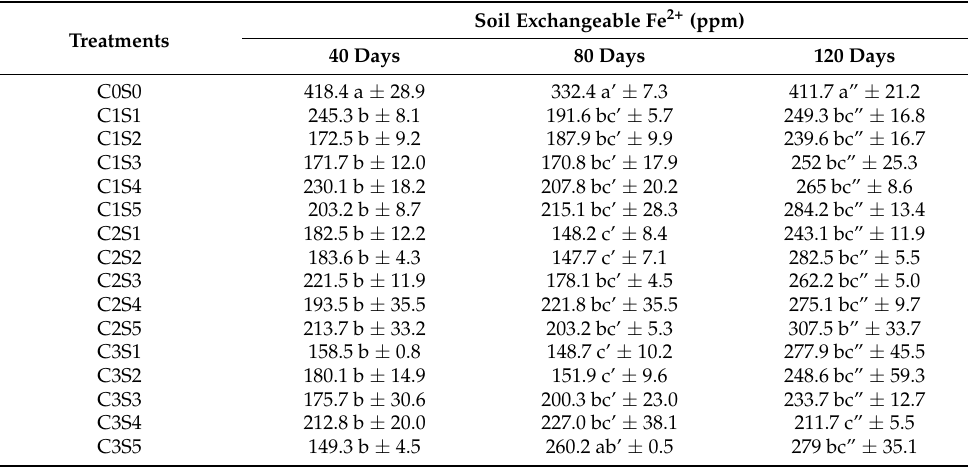
Means (value ± standard error) with different letters within the same column indicate significant differences using Tukey’s test with p ≤ 0.05. Small letters, small letters with ’, and small letters with ” indicate mean comparison at forty, eighty, and one hundred and twenty days incubation,